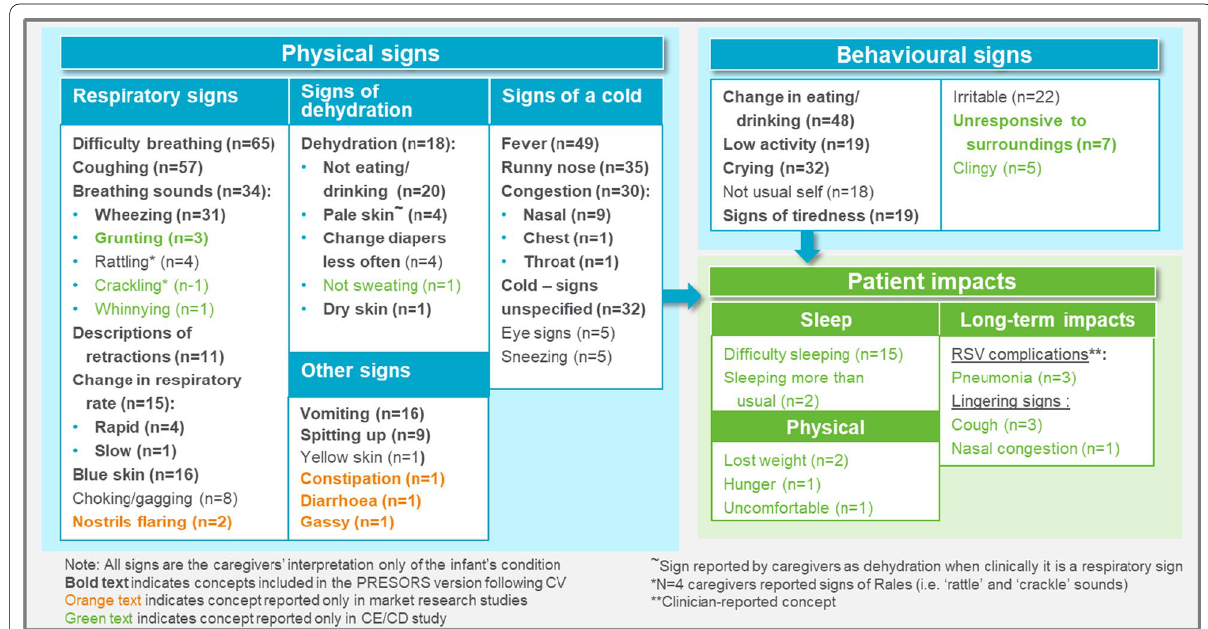
Fig. 1 Conceptual model of signs and impacts of pediatric RSV as reported by caregivers in CE (n which informed PRESORS